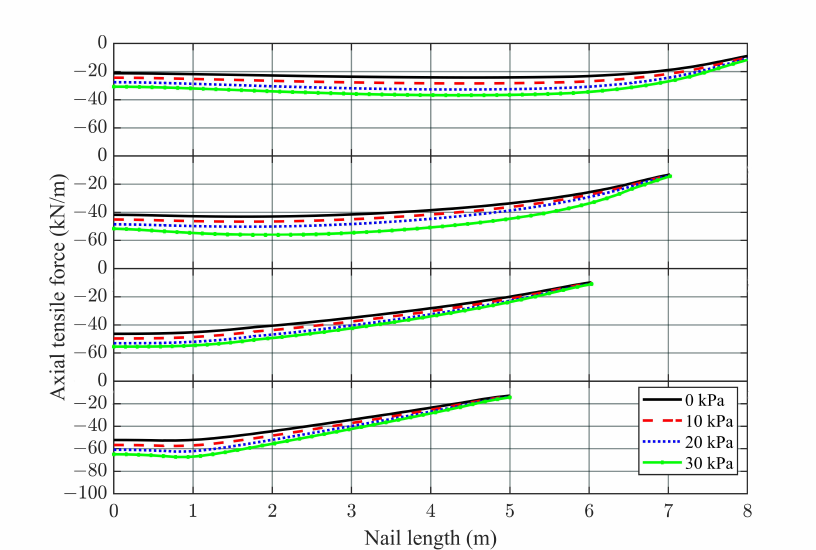
Figure 7. Distribution of nail axial force under various surcharge